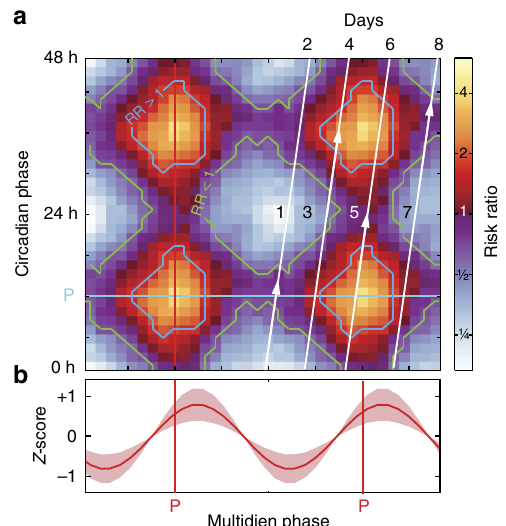
Fig. 6 Average risk ratio (RR) map in the circadian vs. multidien phase- space. a Average of individual RR maps shown in Fig. 5 after alignment to the preferred phases ( “ P ” in axes labels; red vertical line, multidien; cyan horizontal line, circadian). Blue and green contour lines indicate RR > 1 and < 1, respectively, (95% CI excluding RR of one). To illustrate the concept of time-varying seizure risk, white lines depict the hypothetical circular trajectory of a subject with a 24 h circadian and 8-day multidien cycle. Each line covers two circadian cycles and a quarter multidien cycle. When starting on the left line, the subject mostly crosses areas of low seizure RR with the exception of medium RR at times of favored circadian timing (arrowhead). In the second quarter (second line from left), the subject crosses an area where multidien and circadian timing jointly increase seizure RR (arrowhead). In the third quarter (third line from left), the subject stays on an area of increased risk for two circadian cycles by traveling on a vertical band of favored multidien phase (arrowhead). The fourth quarter line joins the bottom of the fi rst line to close the cycle. b Average multidien amplitude ( z -scored) and peak position (just right of the preferred phase). Average circadian cycle is not displayed because the preferred phase was too variable across subjects, but circadian time